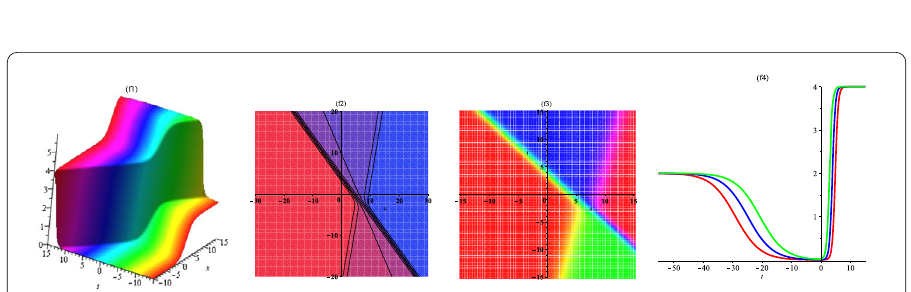
Figure 5 Diagram of 1-lump (2.17) by taking k 1 = 1, k 2 = 2, α = 1, (cid:14) = –1, τ = 2, η 10 = η 20 = 0, R = 2, y = –2 at space (red x = –1, blue x = 0, and green x = 1)